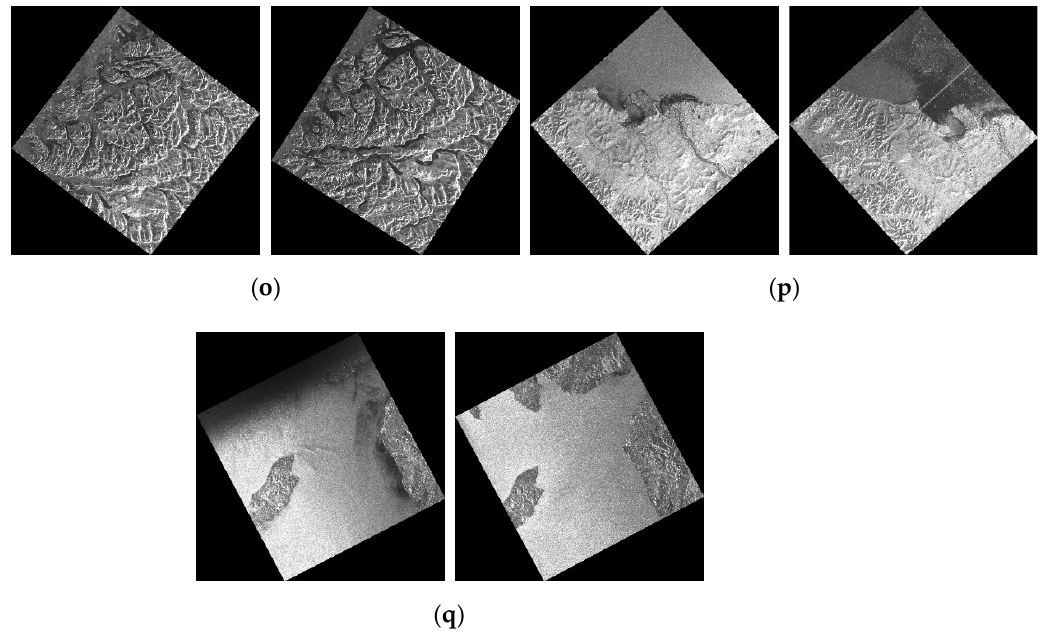
Figure 8. The SAR image datasets ( a – q ) of datasets 1–17. 487